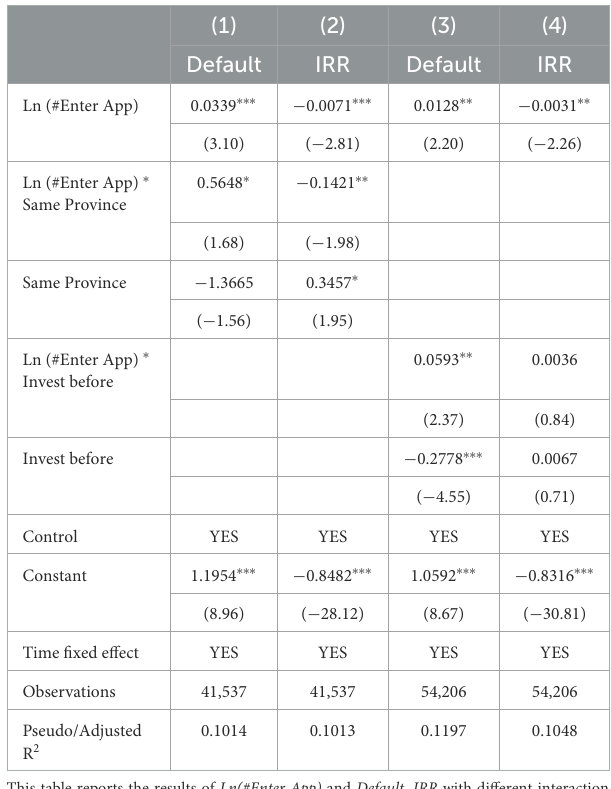
TABLE 7 Mechanism analysis: from the perspective of familiarities